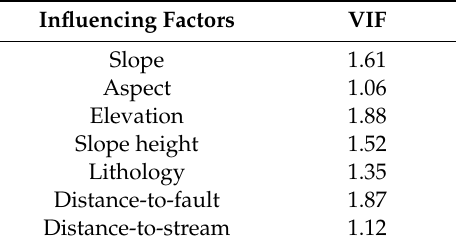
Table 2. Test results of variance inflation factor method of S-GWR.